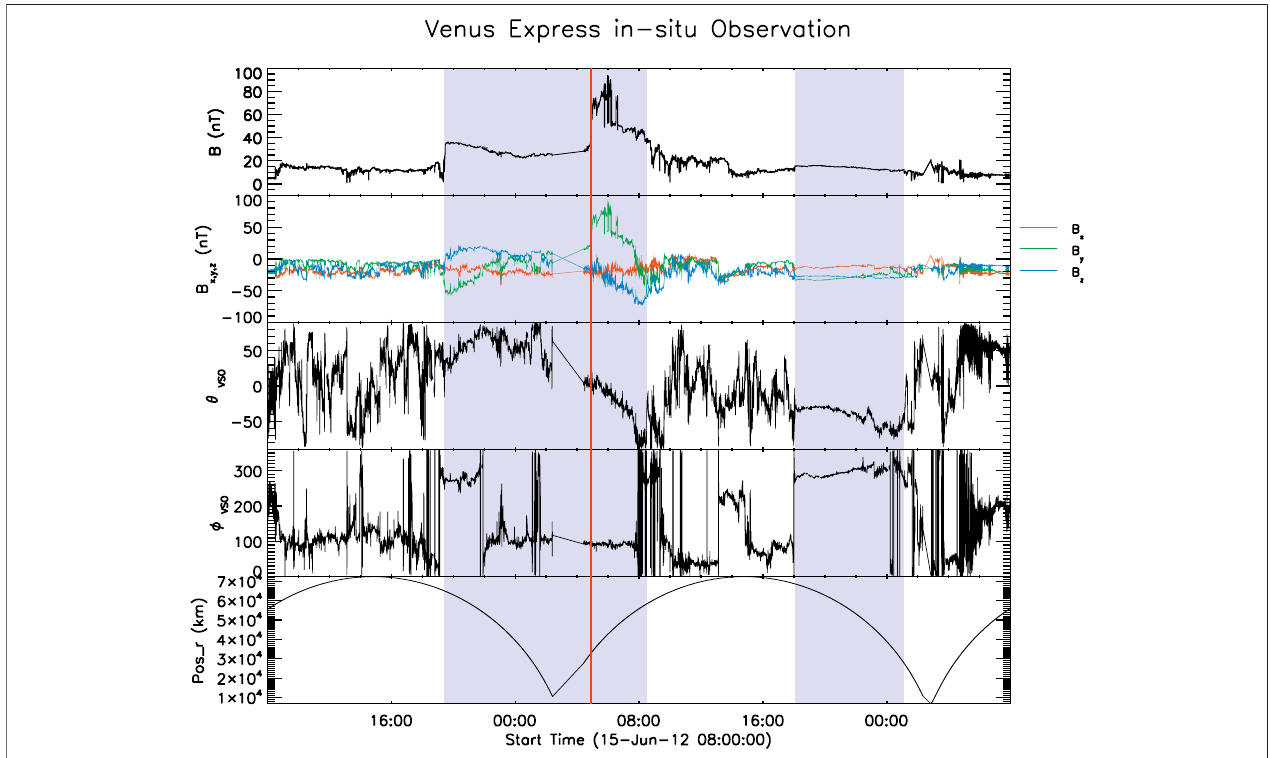
FIGURE 5 | Venus Express observations from 2012 June 16 to 2012 June 18. From top to bottom, the panels display magnetic fi eld strength, x, y, and z components in VSO coordinates, elevation θ and azimuth ϕ of the magnetic fi eld direction in VSO coordinates, and the radial distance of the spacecraft to the center of Venus. The arrival of the shock is indicated by the red vertical line. The intervals of the two ICMEs are shown by the gray shaded areas.